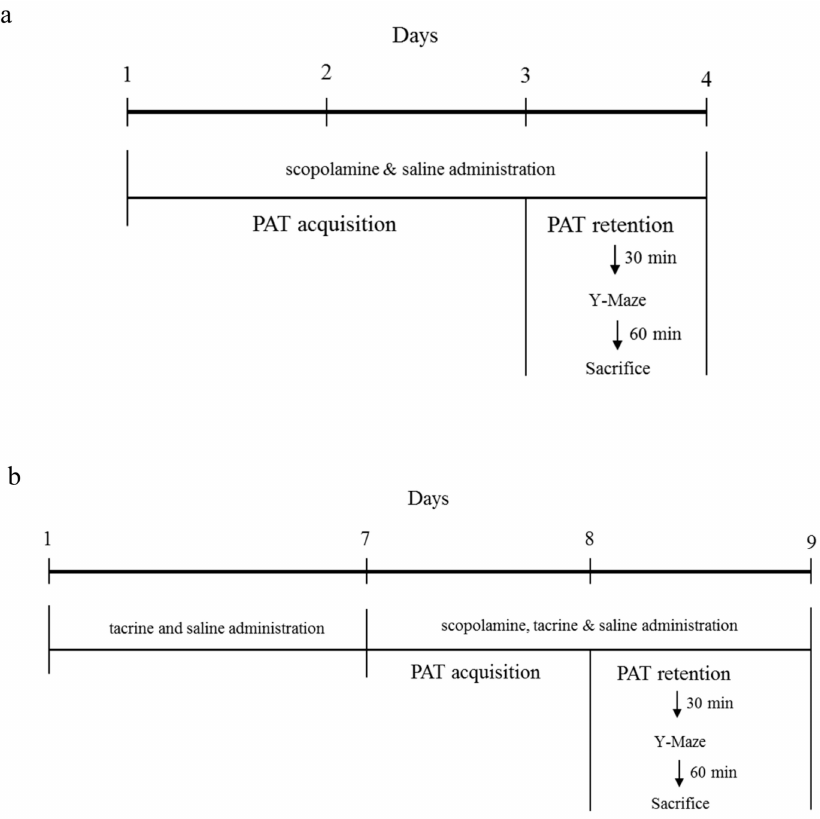
Figure 1. Animal experimental design: ( a ) Comparison of outbred ICR and inbred C57BL/6 strain; ( b ) Comparison of C57BL/6 substrains-C57BL/6N and C57BL/6J. PAT: passive avoidance